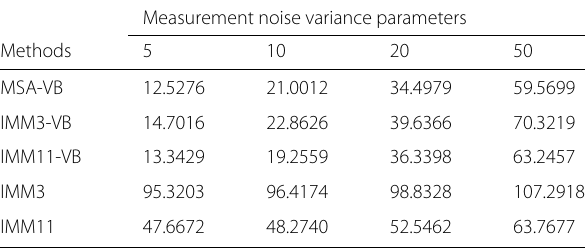
Table 2 Average RMSEs in position with different measurement noise variance parameters for the Experiment 1 Measurement noise variance